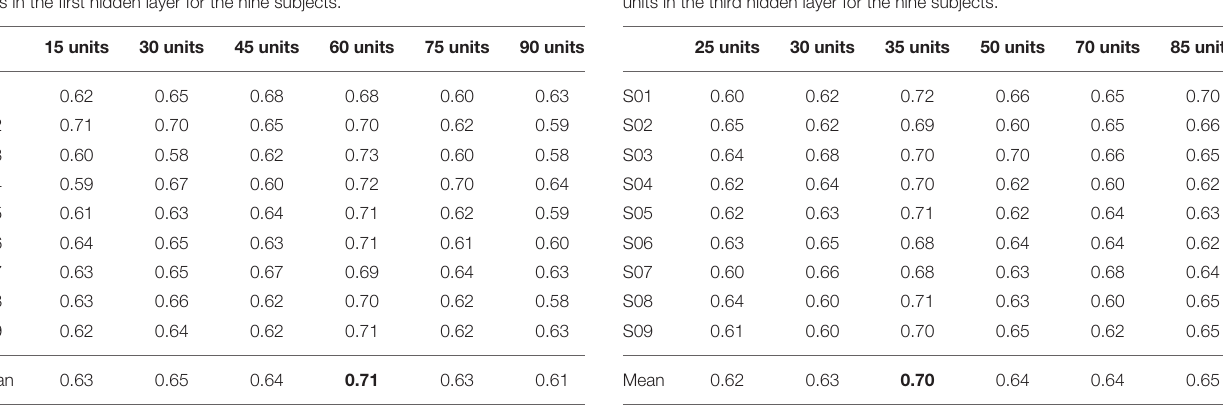
TABLE 4 | Comparison of classification accuracies based on different numbers of units in the third hidden layer for the nine